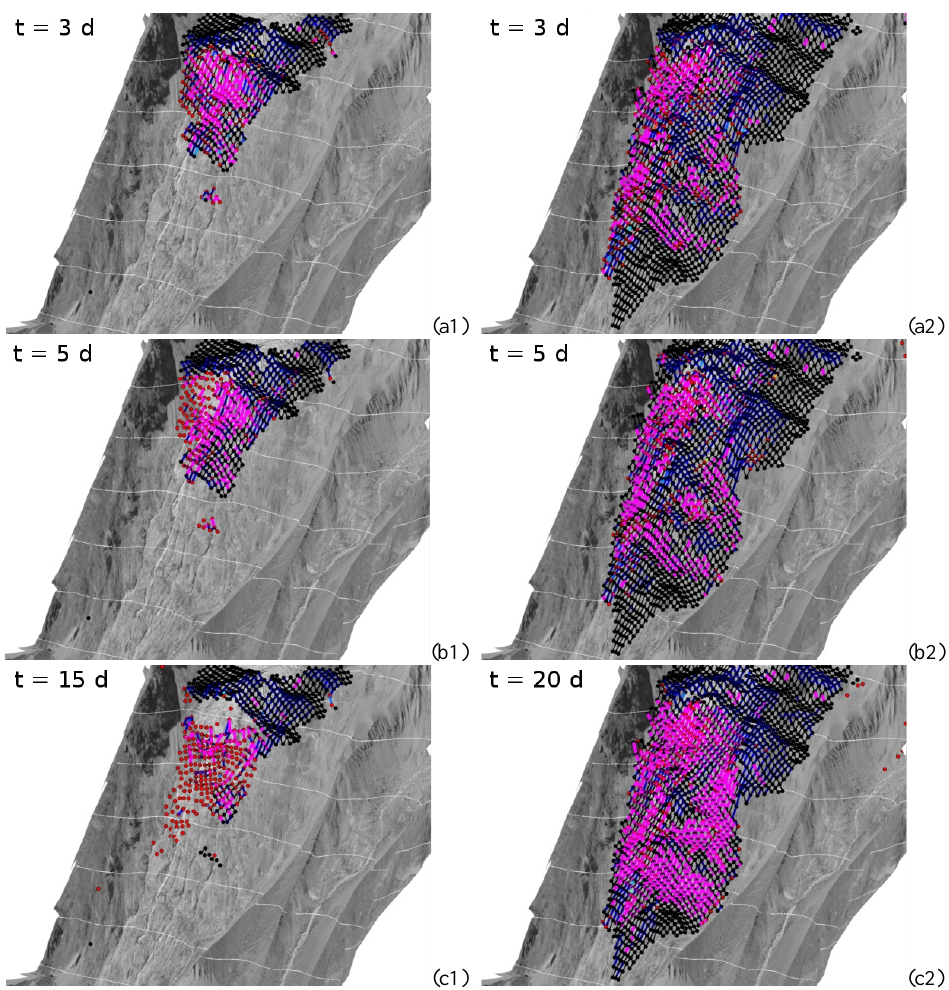
Fig. 10. Snapshots describing the rupture progression for the glacier geometry in the years 2000 (left) and 1982 (right), with a constant friction coefficient. For the sake of simplicity, blocks are represented as small circles where the black coloured circles indicate static blocks and the red ones the sliding blocks. The colour of a bond evolves from blue to red as the stress changes from larger than the critical stress s ? (Faillettaz et al., 2010, i.e. the minimum stress such that the material will eventually fail) to close to rupture. Bonds where stress is lower than s ? are drawn in thin black. Bonds in compression are coloured magenta.